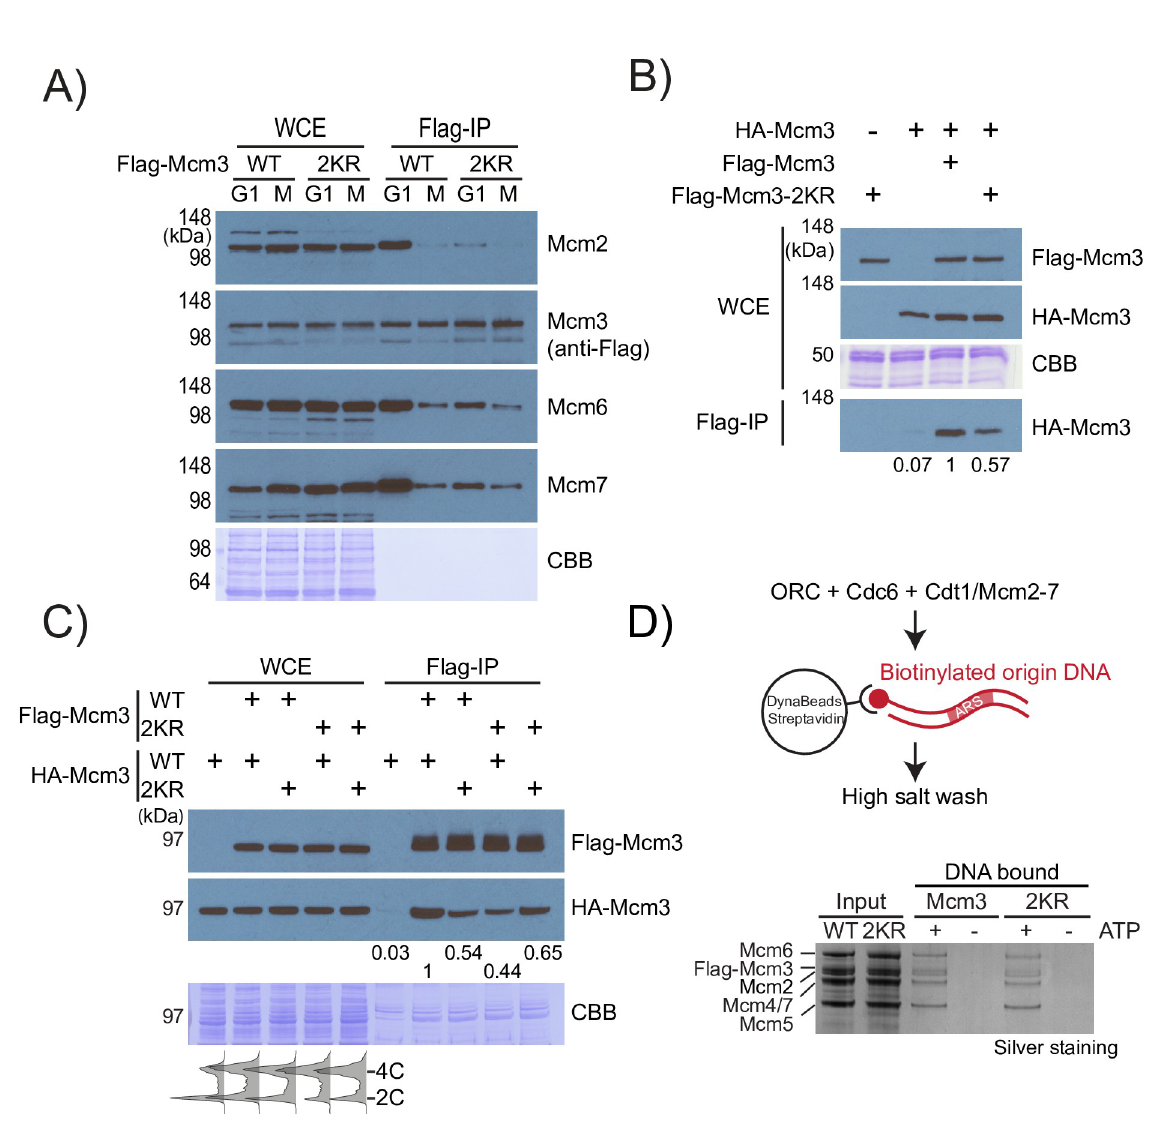
Fig 4. mcm3-2KR reduces MCM complex formation in vivo , but not in vitro . (A) Effects of mcm3-2KR and cell cycle stages on the association among MCM subunits. Flag-Mcm3 from the indicated cells was immuno-purified using anti-Flag affinity resins and probed by various anti-MCM antibodies. (B) G1 arrested HA-Mcm3 haploids expressing extragenic WT Flag-Mcm3 or Flag-Mcm3-2KR were used for anti-Flag immunoprecipitation. Co-purified HA-Mcm3 was only observed when both tagged Mcm3 proteins were present, confirming the specificity of this assay in detecting MCM-DH. A lower level of co-purified HA-Mcm3 was found to associate with Flag-Mcm3-2KR. Densitometry was used to quantify the Mcm3 protein bands; the relative intensity to the most intense band is shown. (C) Diploid cells expressing Flag or HA tagged Mcm3, WT or 2KR, were used for anti-Flag immunoprecipitation assay. Co-purified HA-Mcm3 is maximal in WT diploids, lowest in MCM3/mcm3-2KR heterozygous diploids and intermediate in homozygous mcm3-2KR diploids. Thus, wild-type Mcm3 is preferentially used to make MCM-DH, and such preference is not available in the homozygous mcm3-2KR diploid. CBB: Coomassie blue staining. The numbers below the anti-HA Western blot indicate the relative amount of HA-Mcm3 based on densitometric analysis. (D) In vitro MCM-DH loading using immobilized origin-containing DNA template, Cdc6, ORC and MCM-Cdt1, which contains either WT or 2KR mutant of Flag-Mcm3. Following high salt wash, the loaded MCM-DH was eluted and detected by silver staining. The requirement of ATP confirmed MCM-DH loading, showing that mcm3-2KR does not affect MCM-DH loading in vitro